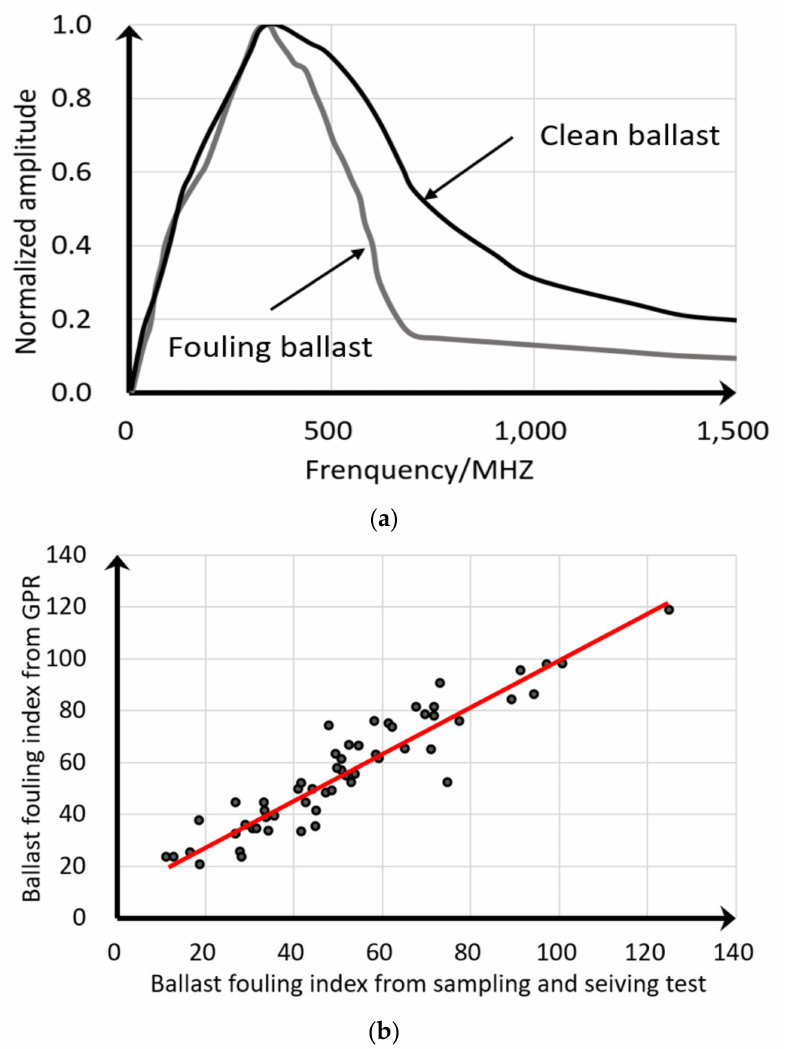
Figure 11. Frequency-domain GPR signal for ballast fouling level estimation (figure modified af- ter [108]): ( a ) Frequency characteristics at different ballast fouling levels. ( b ) Ballast fouling index Correlation of GPR inspection and in situ sampling and